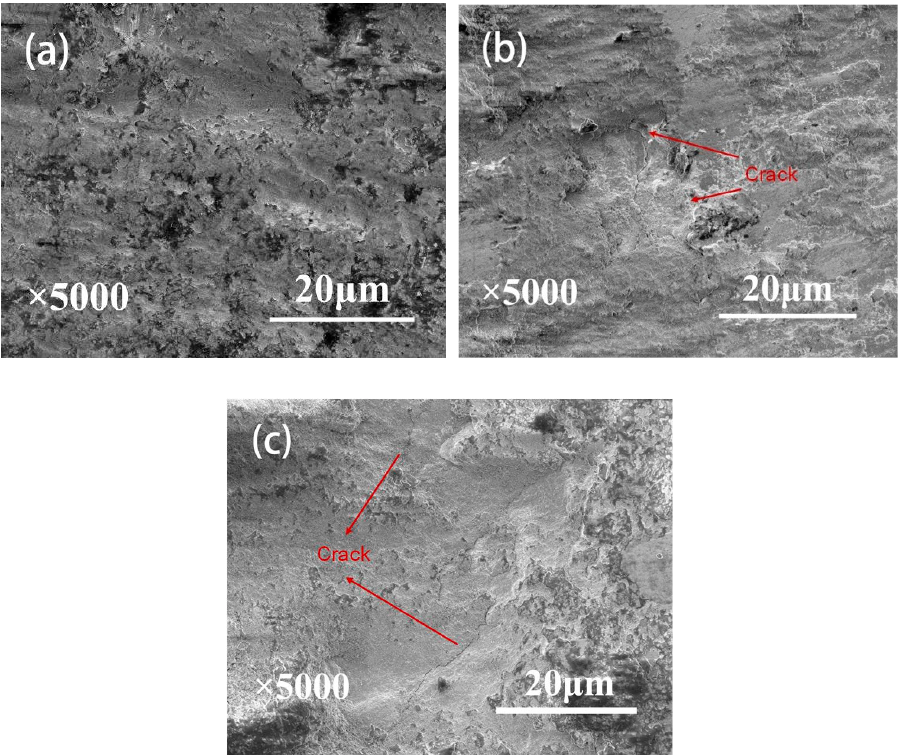
Figure 11. SEM morphologies of the wear scars of coatings after the oxidation temperature of 300 °C :